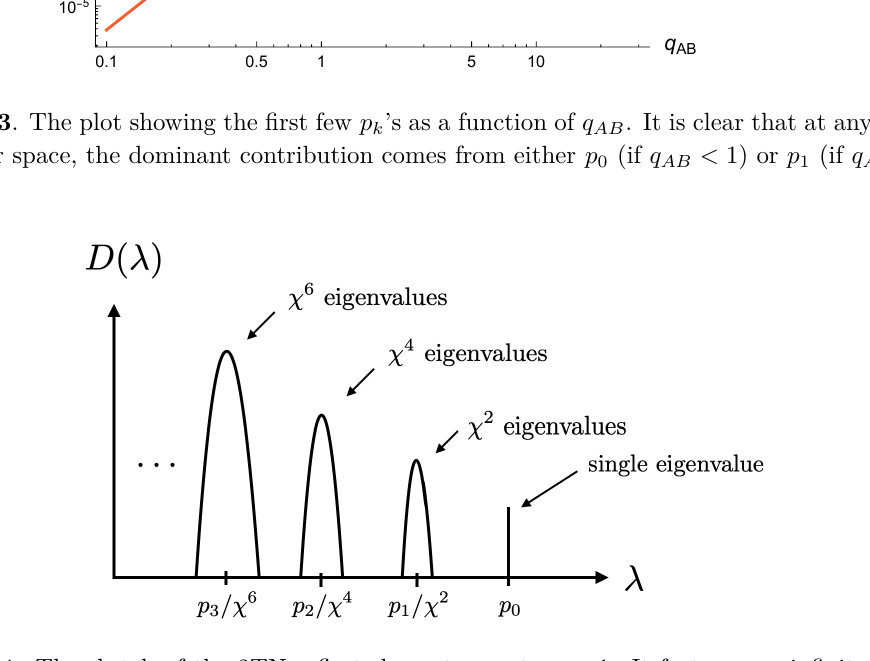
Figure 14 . The sketch of the 2TN reflected spectrum at m = 1 . It features an infinite tower of eigenvalues labeled by the sector number k . Note that the eigenvalues of the k > 0 sectors are drawn with a width here. This effect comes from taking the external bond dimensions χ large but finite, which we will investigate in detail in section